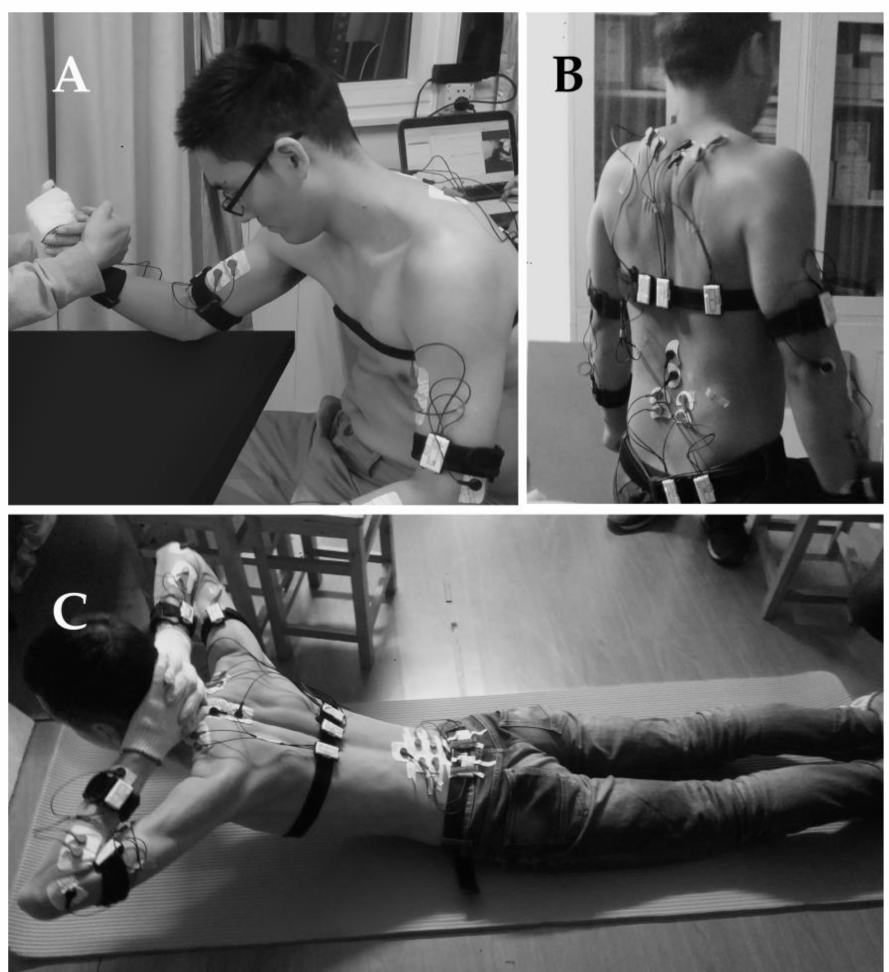
Figure 2. The MVC test for the muscles [35]: ( A ) MVC test for biceps brachii muscle. The subject endeavored to flex the arm while in a seated position and his forearm was held tightly. ( B ) MVC test for upper trapezius muscle. The subject lifted the shoulder utmost while his arms were fixated. ( C ) MVC test for multifidus muscle. The subject endeavored to raise the chest laying in a prone position and his ankles were held